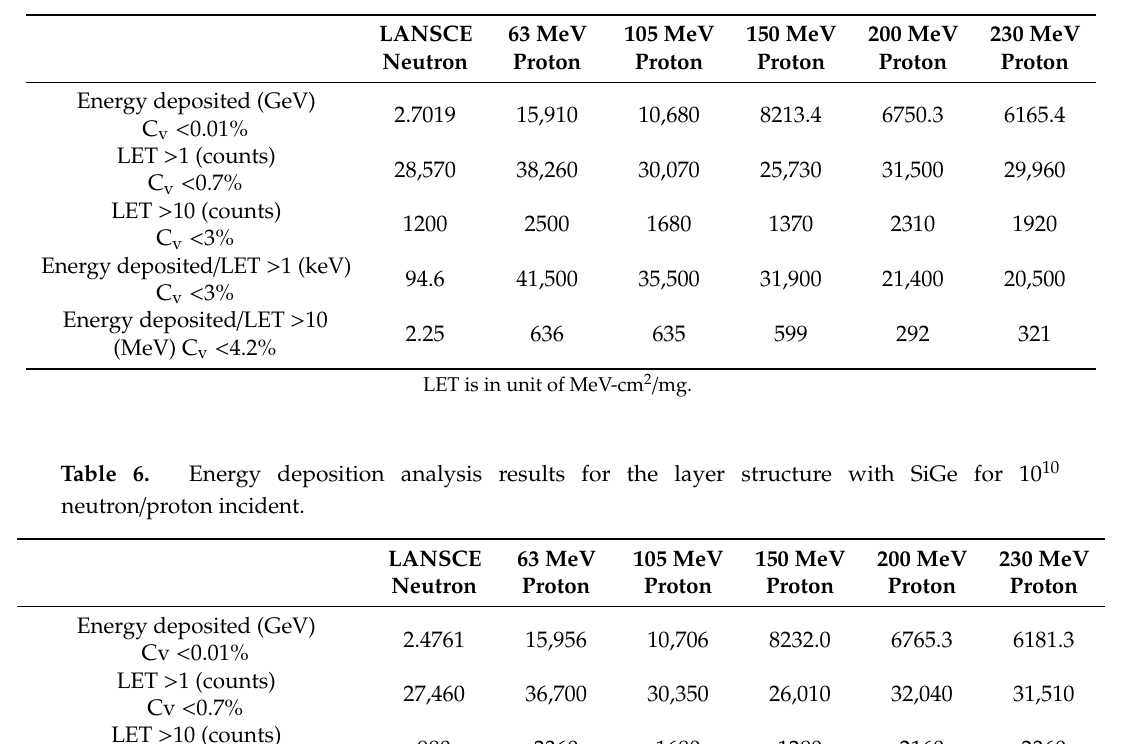
Energy deposition analysis results for the layer structure without SiGe for 10 10 neutron / proton incident.